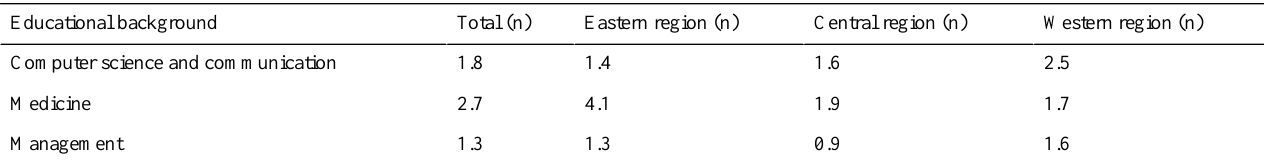
Table 1. Educational background of the telemedicine staff in the tertiary hospitals of different regions in China (person per